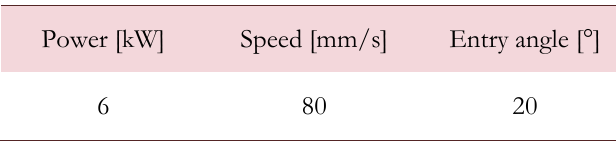
Table 3: Process parameters.